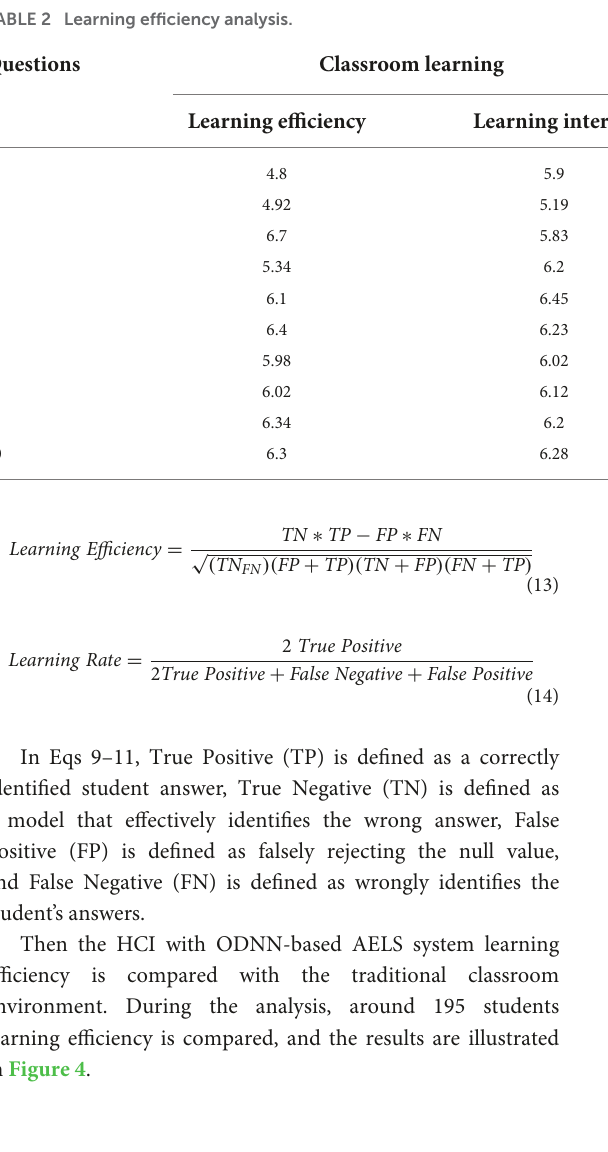
FIGURE6 Error rate analysis.